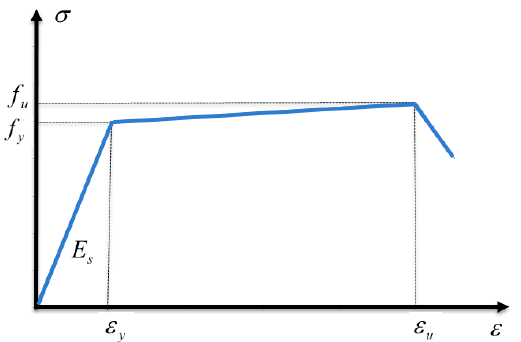
Figure 19. Constitutive relationship of the stud and shear reinforcement.